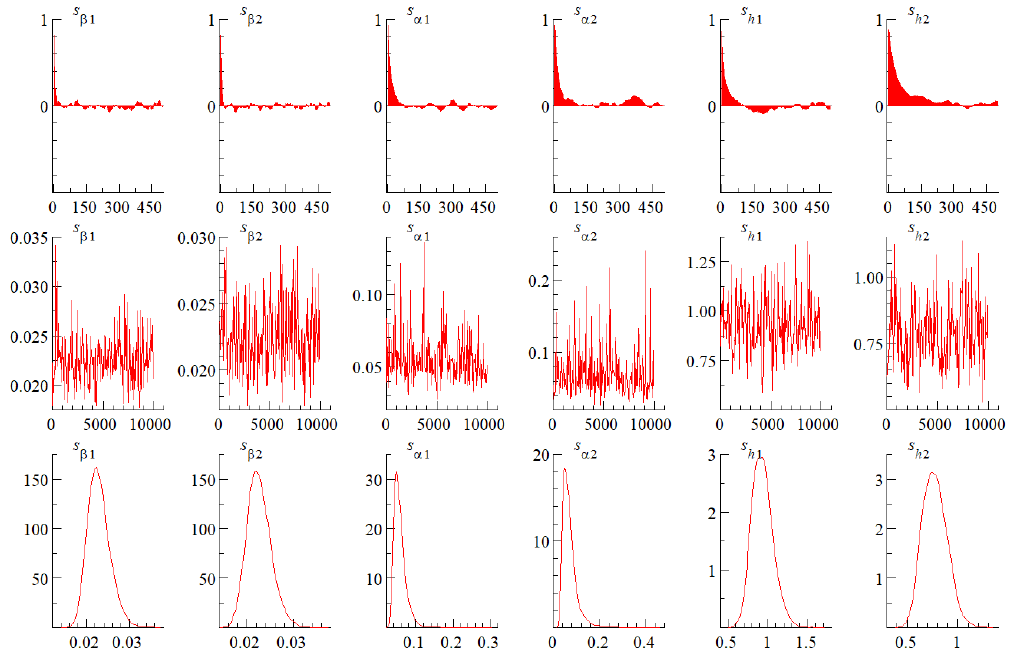
Figure 1. Estimation results of the time-varying parameter (TVP) regression model for the simulated data.